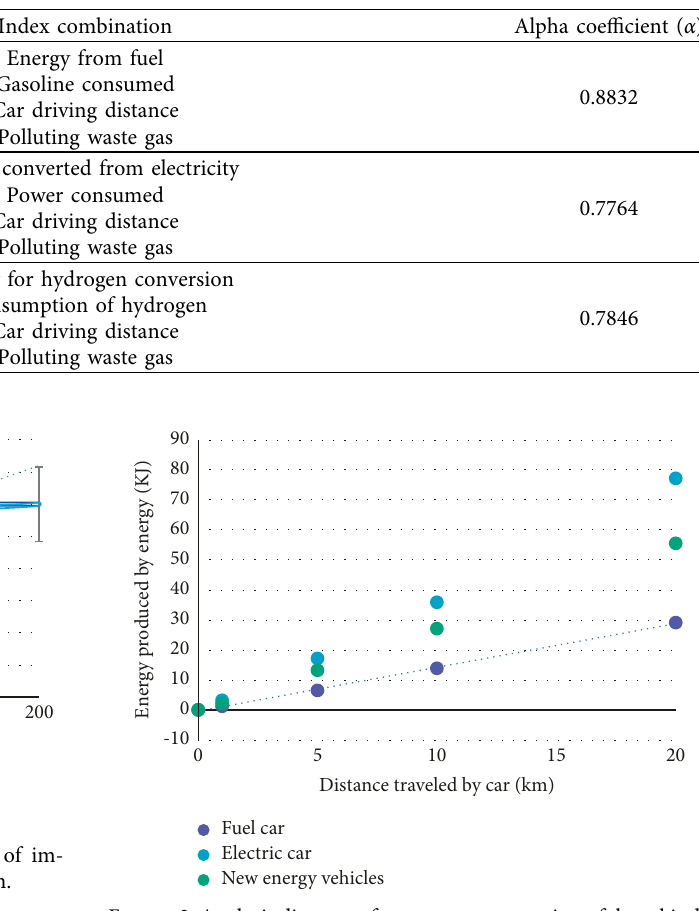
Table 3: Analysis table of evaluation index system based on index reliability test.